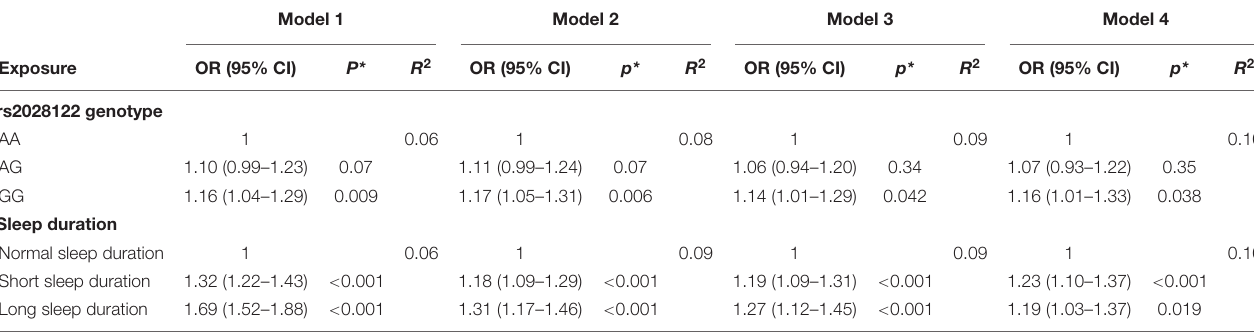
TABLE 5 | Odds ratios and 95% CIs for the association between RORA rs2028122 genotype and PD, separated by sleep duration and RORA rs2028122 genotype, respectively.